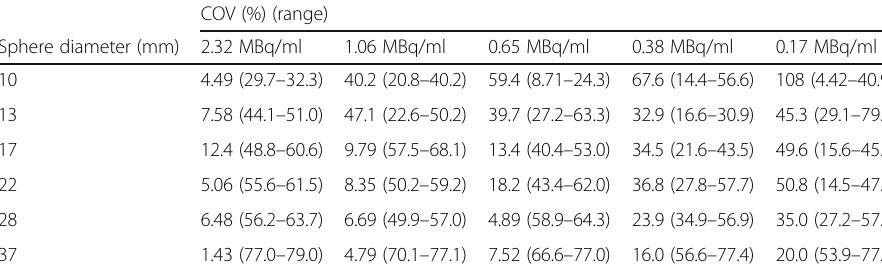
Table 4 Intra-center coefficient of variation (COV) of recovery coefficients (RCs) for each sphere size and activity concentration COV (%) (range) Sphere diameter (mm) 2.32